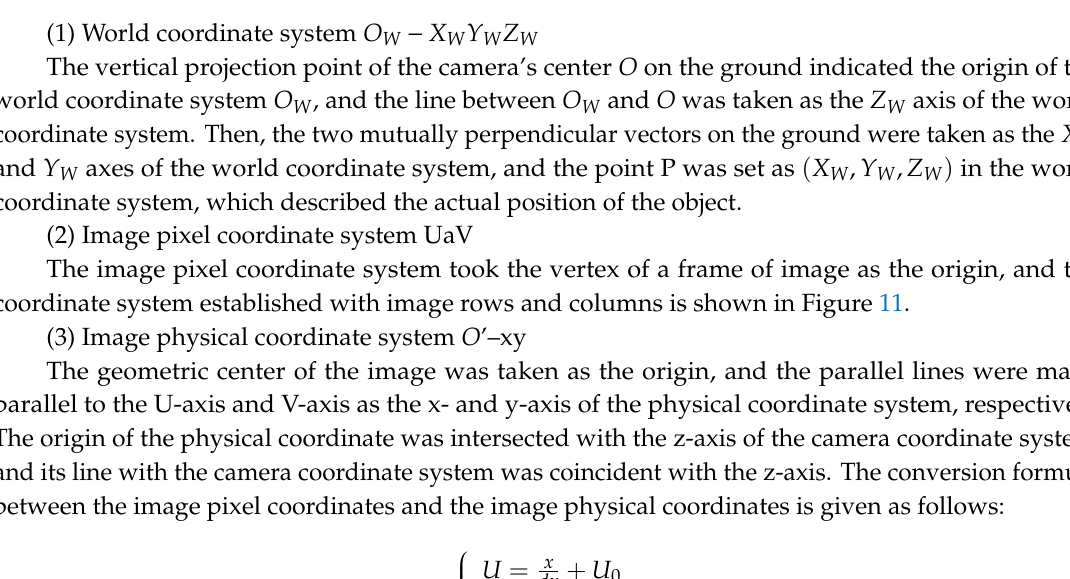
Figure 11. Camera coordinate system diagram.